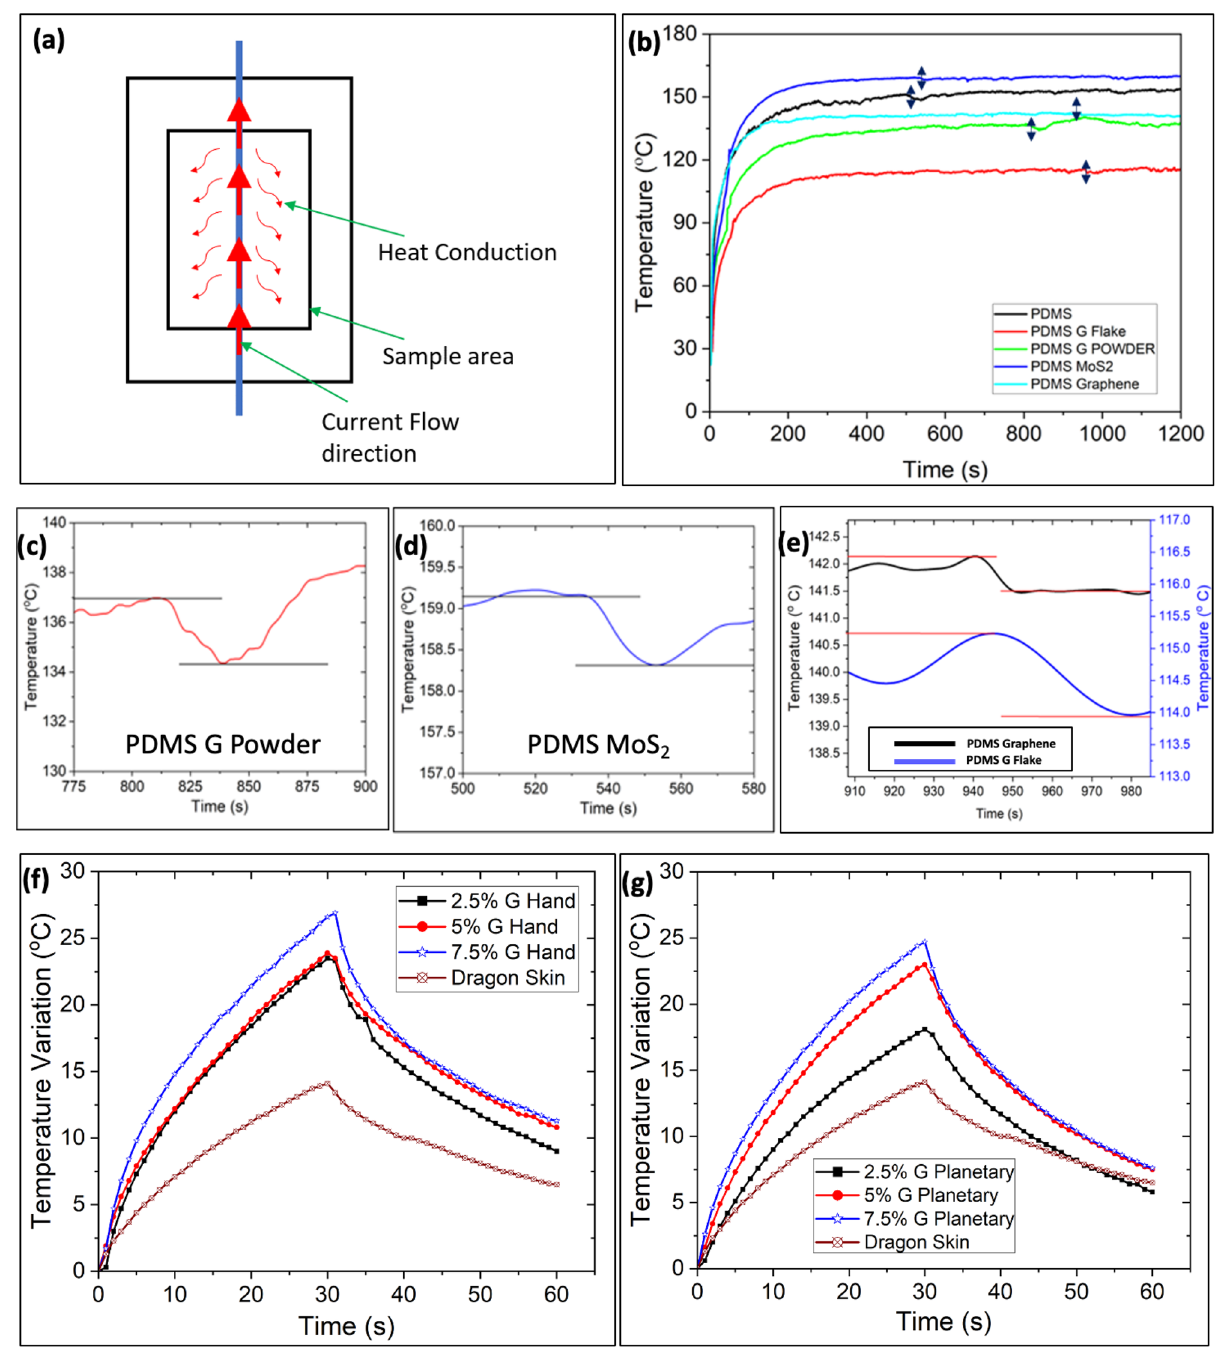
Figure 6. ( a ) Schematic of micro-scale curing analysis using nichrome wire in a 3D printed chamber. ( b ) Curing analysis of different fillers with PDMS polymer (vertical double arrow line depicts curing. Rapid temperature change during curing for ( c ) PDMS G powder, ( d ) PDMS MoS 2 , ( e ) PDMS graphene, and PDMS G flake. Thermal characteristics curve of dragon skin, 2.5%, 5%, 7.5% G Samples (each sample was heated by a SpotIR heater for 30 s and then cooled down for another 30 s) prepared by ( f ) Hand mixing and ( g ) Planetary